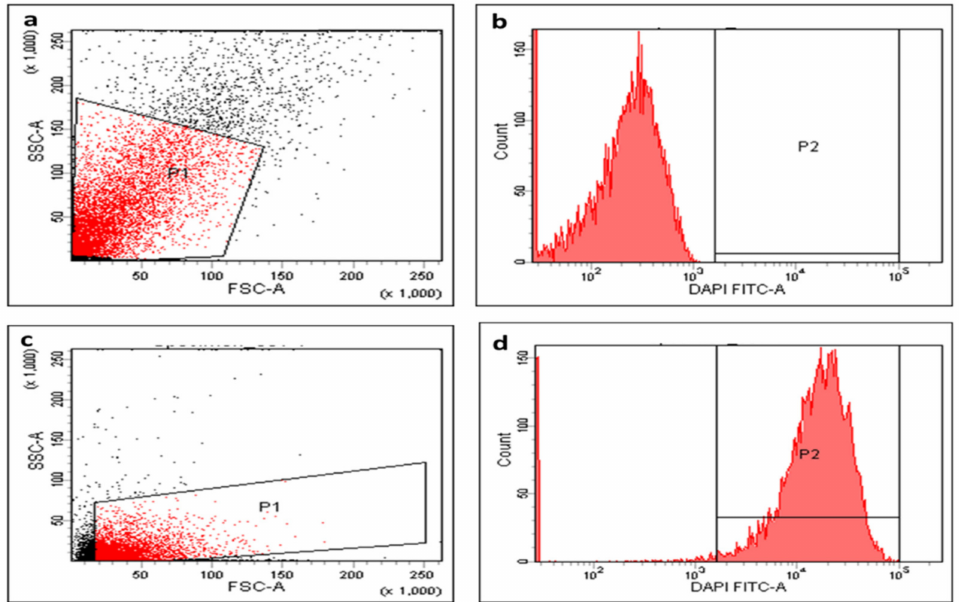
Figure 10. Flowcytometric chart ( a ) dot plot, ( b ) histogram (fluorescent gap = 67.1%) before treatment, ( c ) dot plot, and ( d ) histogram (fluorescent gap = 35.1%) after treatment of a representative S. aureus isolate with the green-synthesized AgNPs.